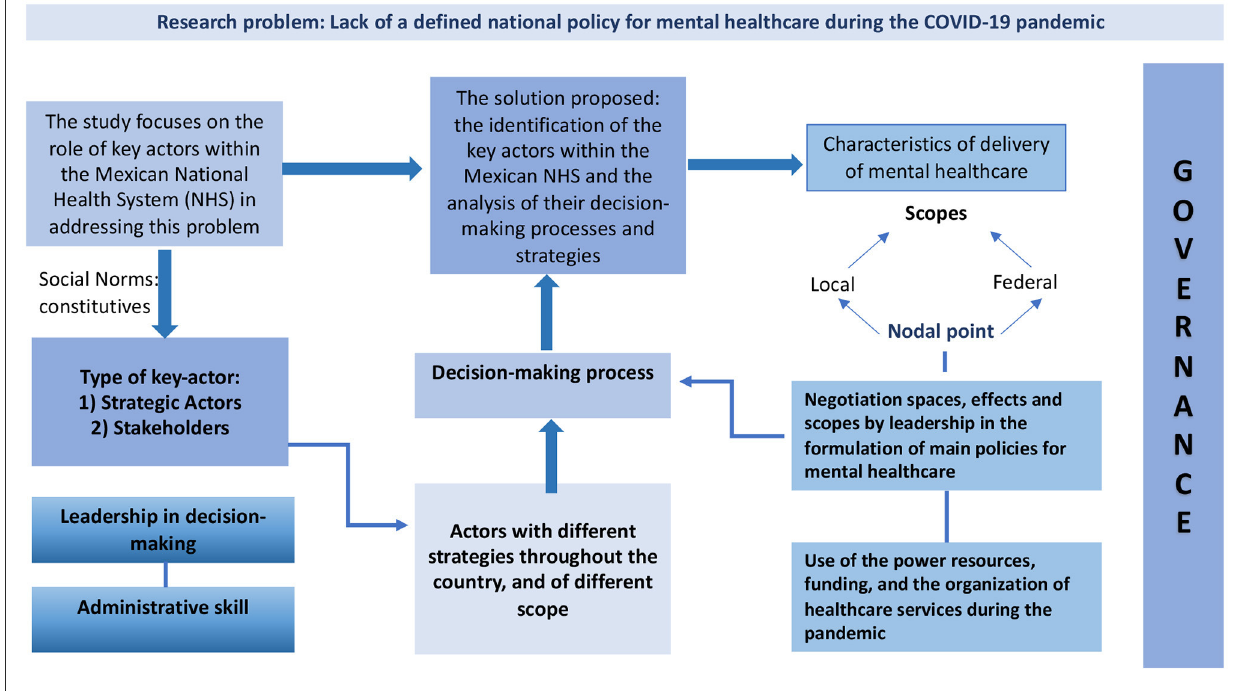
FIGURE2 Theoretical contribution of the research: examination of the governance approach to mental healthcare during a pandemic, México, 2020.